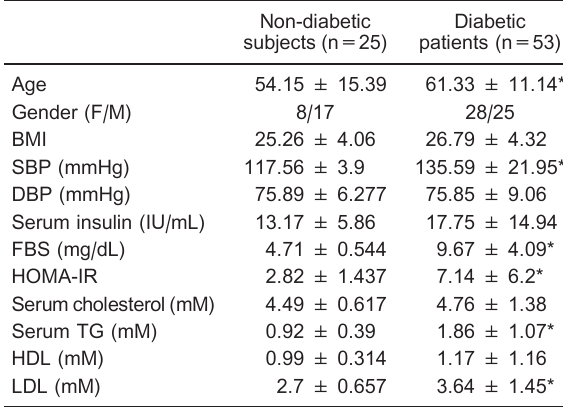
Table 1. Clinical characteristics of the non-diabetic healthy control subjects and diabetic